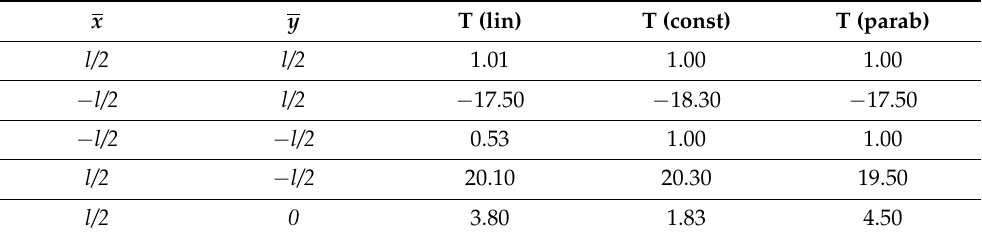
Table 12. Temperatures in the corners of the copper plate and at the midpoint of the plate’s surface facing the heated air inlet to the room for different initial conditions, and v a = 0.5 m/s, T c = − 19 ◦ C, and t = 300 s. x y T (lin)